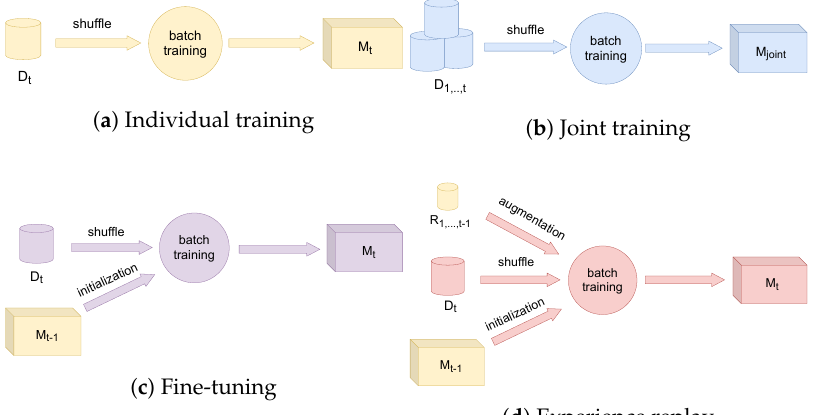
Figure 2. The training setup. ( a ) In the individual training approach, the model is trained on a new dataset. ( b ) In the joint training, the model is trained on all available datasets. ( c ) In the fine-tuning approach, the model is trained on a new dataset with the initial parameters obtained from training on the previous datasets. ( d ) In the experience replay approach, at first, the model is initialized with the parameters attained from the previous learning stages on the former datasets; then, the model is trained on a new dataset and a replay memory (that is randomly selected from the former